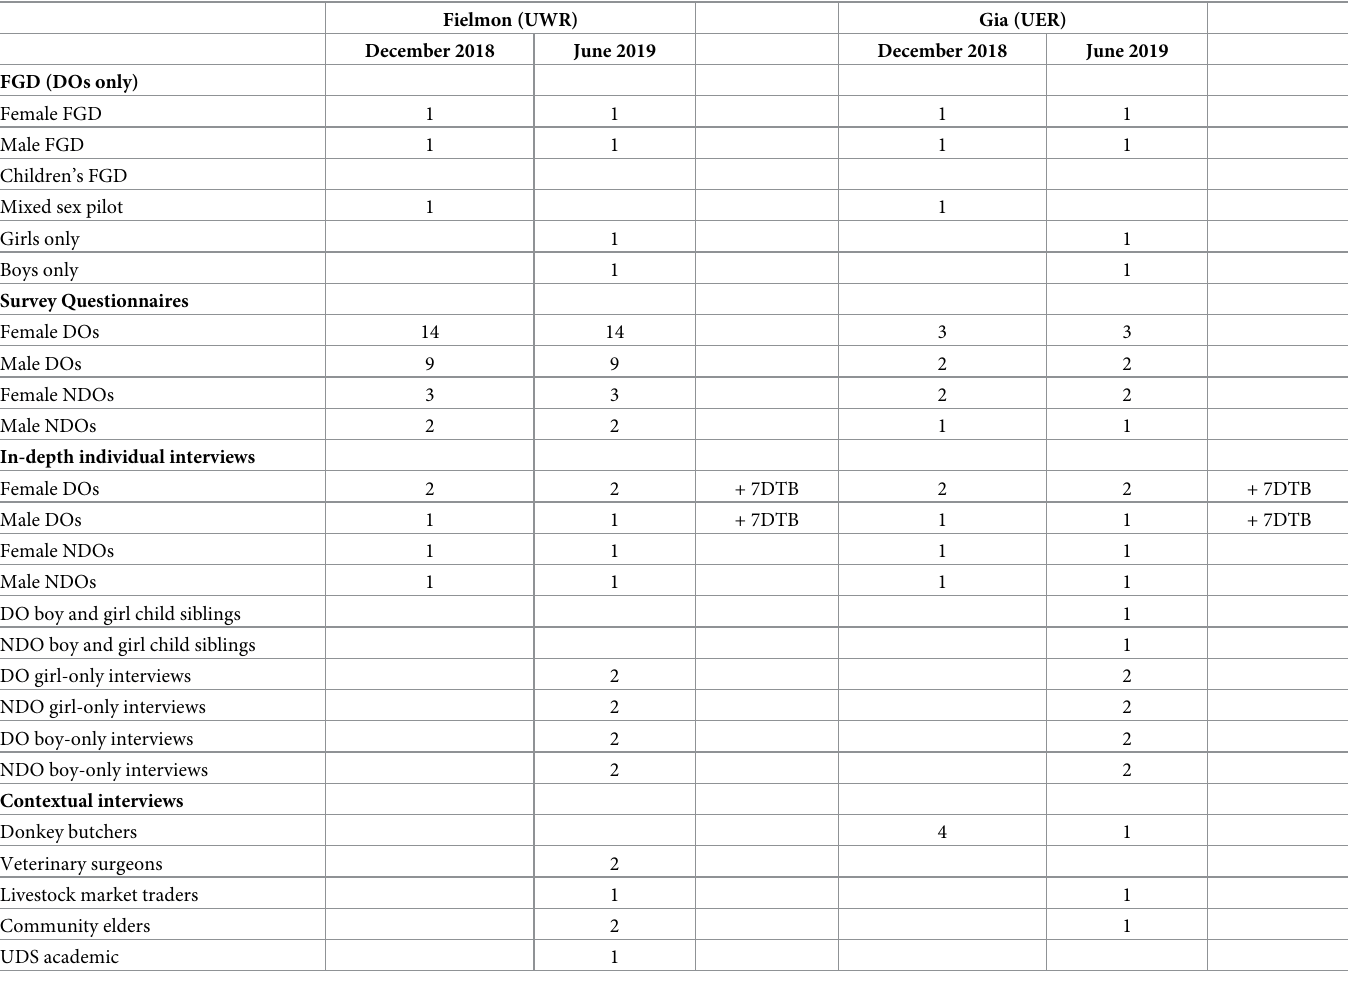
Table 1. Study design. Source: Maggs, 2022